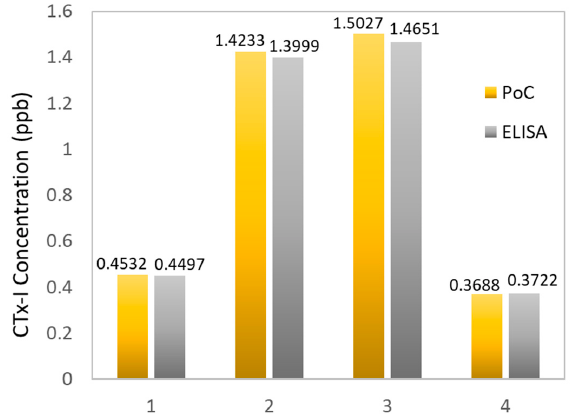
Figure 8. Comparison between the results collected from the PoC device and the standard ELISA.